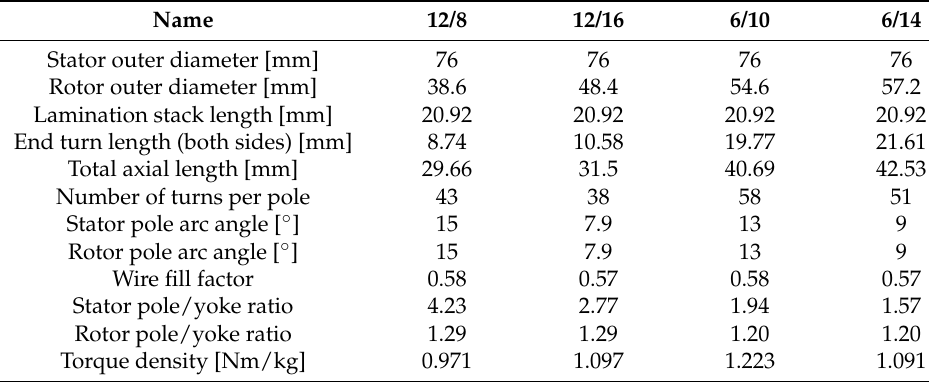
Table 6. Main geometrical properties of final SRM